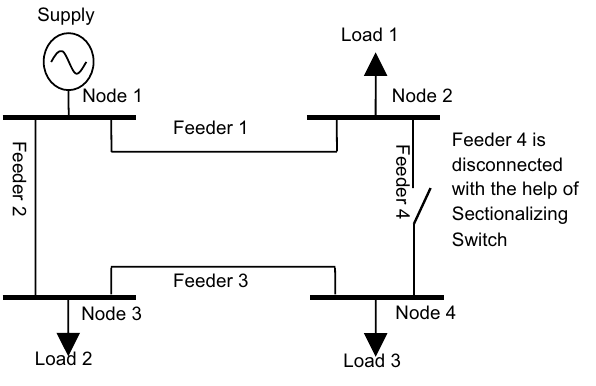
Fig. 2 A 4-node reconfigured radial